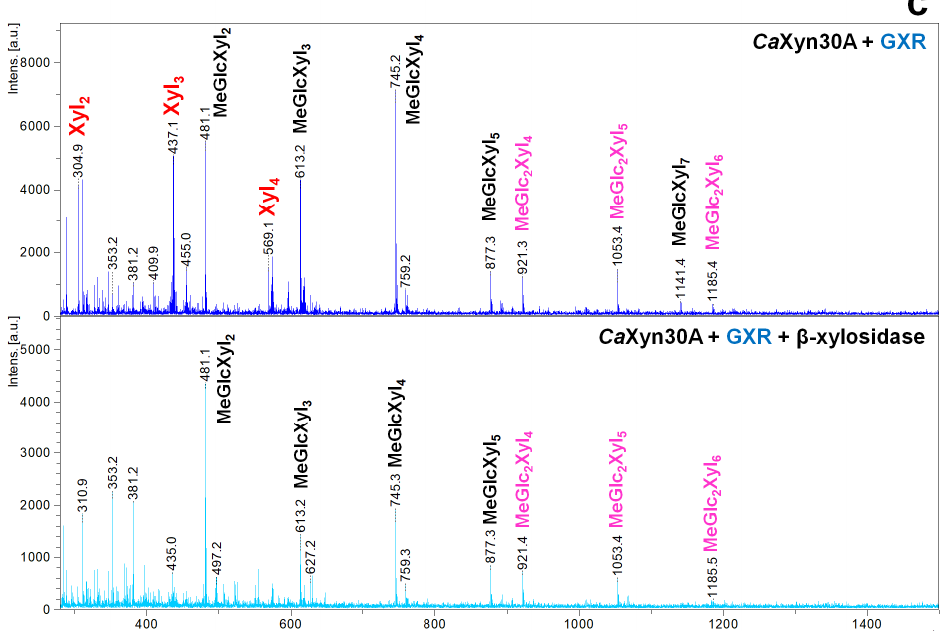
Figure 4. MALDI ToF MS analysis of the hydrolysates of GX ( a ), GXE ( b ) and GXR ( c ) generated by Ca Xyn30A and their subsequent hydrolysis by β -xylosidase.